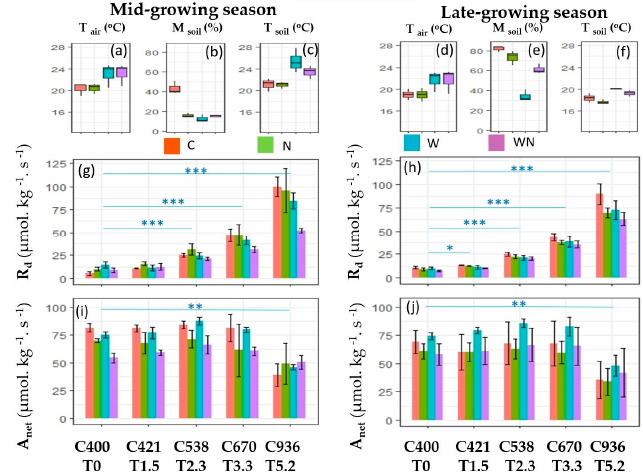
Figure 1. The dark respiration (Rd) ((g) for the mid-growing season, (h) for the late-growing season) and net photosynthesis (Anet) ((i) for the mid-growing season, (j) for the late-growing season) of A. glaucophylla in both CO 2 and temperature increments (CTI) conditions stimulating future climate scenarios for the year 2100 in the Control (C-red bars), N addition (N-green bars), warming (W-blue bars) and both N addition and warming (NW-purple bars) plots. Error bars represent the standard error of the mean (n = 3). Stars indicate the p -value of the Tukey test for significant differences of Rd and Anet between levels of CTI (*: p < 0.05, **: p < 0.01, ***: p < 0.001). Box plots show environmental variables, including: air temperature (T air ) ((a) for the mid-growing season), (d) for the late-growing season), soil moisture (M soil ) ((b) for the mid-growing season), (e) for the late-growing season), and soil temperature (T soil ) ((c) for the mid-growing season), (f) for the late-growing season). Moreover, R d increases due to the CTI were regulated by N and W (Table 1). A sig- nificantly interactive effect (F 1,38 = 4.1, p = 0.0071) between N and CTI on R d was detected in T. cespitosum during the mid-growing season. In particular, N accelerated the increases of R d due to C670T3.3 and C936T5.2 by 30% and 25%, respectively (Figure 4g). In contrast, W reduced the positive effects of CTI on R d in A . glaucophylla in the mid-growing season Atmosphere 2022 , 13 , x FOR PEER REVIEW (F 4,38 = 7.9, p = 0.0076) and G. bigeloviana in the late growing season (F 4,38 = 10.6, p = 0.0045). In detail, W dampened the increase of R d in A. glaucophylla in C670T3.3 by 23% and C936T5.2 by 30% during the mid-growing season (Figure 1g). W also modified the effects of CTI on R d in G. bigeloviana during the late growing season in the C670T3.3 and C936T5.2 conditions with 29% and 30% decreases, respectively (Figure 2h). However, W and N have no interaction effects on the response of R d to CTI in all measured plants (Table 1).